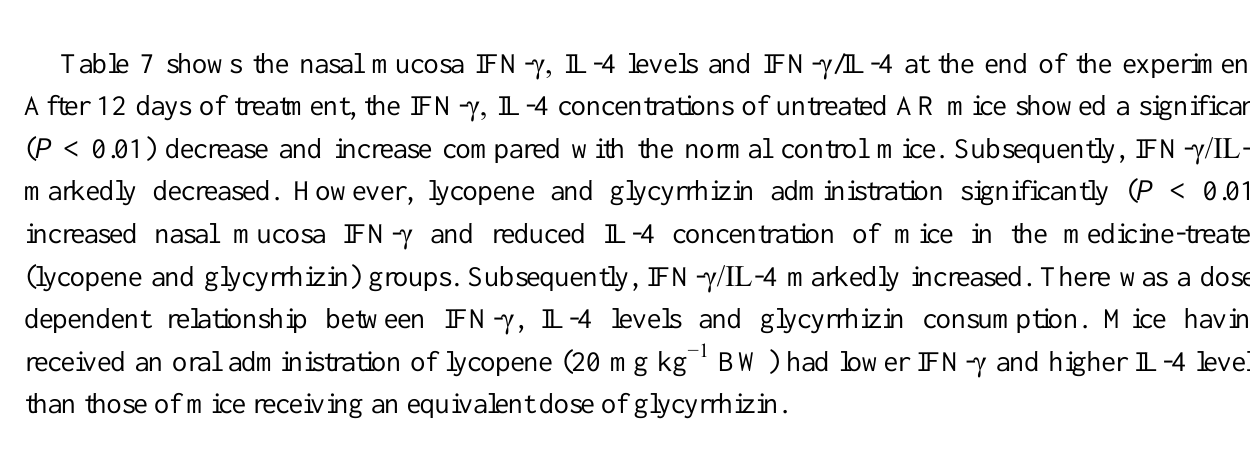
Table 5. Blood SOD, CAT, GSH-Px and TAOC activities in different groups.